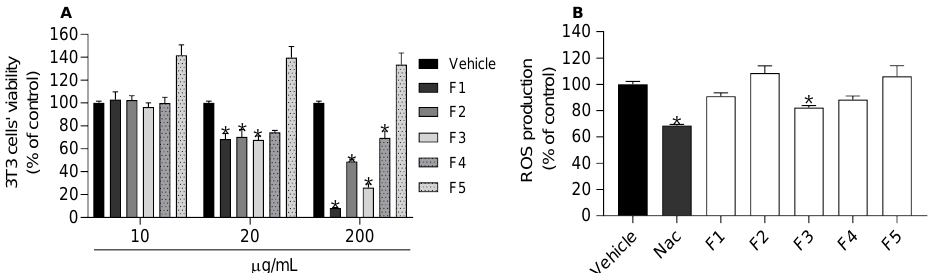
Figure 7. Effects of Saccorhiza polyschides fractions (10–200 µ g/mL) on 3T3 cell’s viability after 24 h of treatment. ( A ) Reactive oxygen species (ROS) levels (% of control) on 3T3 fibroblasts following exposure to UV radiation (12.5 mJ/cm 2 ; 1 h), in the presence/absence of Saccorhiza polyschides fractions (10 µ g/mL) and N -acetyl- L -cysteine (NAC, 10 µ g/mL) ( B ). Symbols (*) represent significant differences (one-way ANOVA, Dunnett’s test; p < 0.05) when compared to vehicle. At 10 µg/mL, none of the fractions showed cytotoxicity and so, this concentration was selected for the photoprotective assay. The ethyl acetate fraction (F3) was the only fraction that exhibited photoprotective ability, reducing the ROS production (82.3 ± 1.5%) induced by UV exposure to values close to those of the standard (NAC) (68.6 ± 0.9%) (Fig- ure 7B).